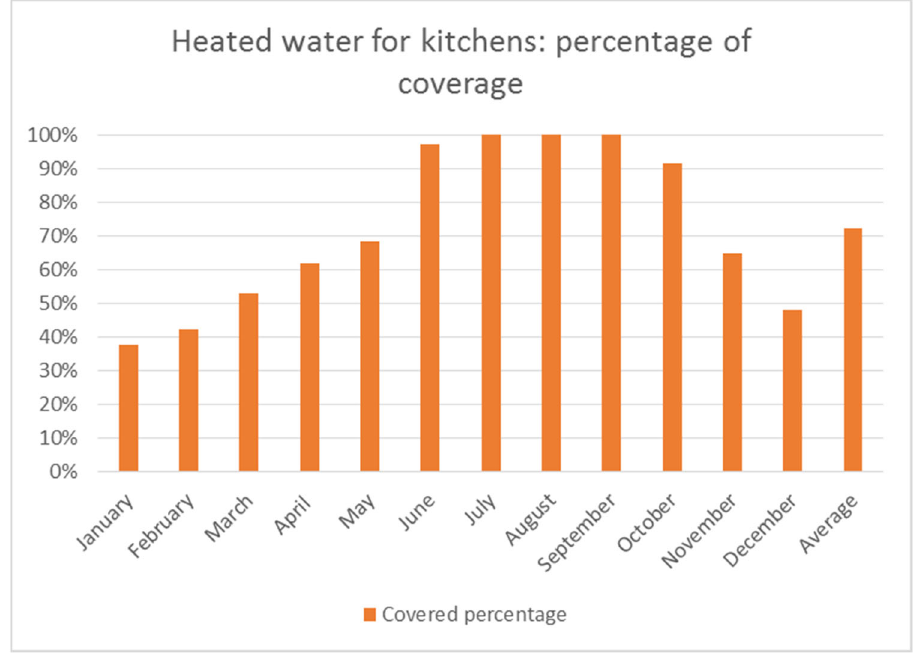
Figure 12. Heated water, required by kitchens, coverage percentage.